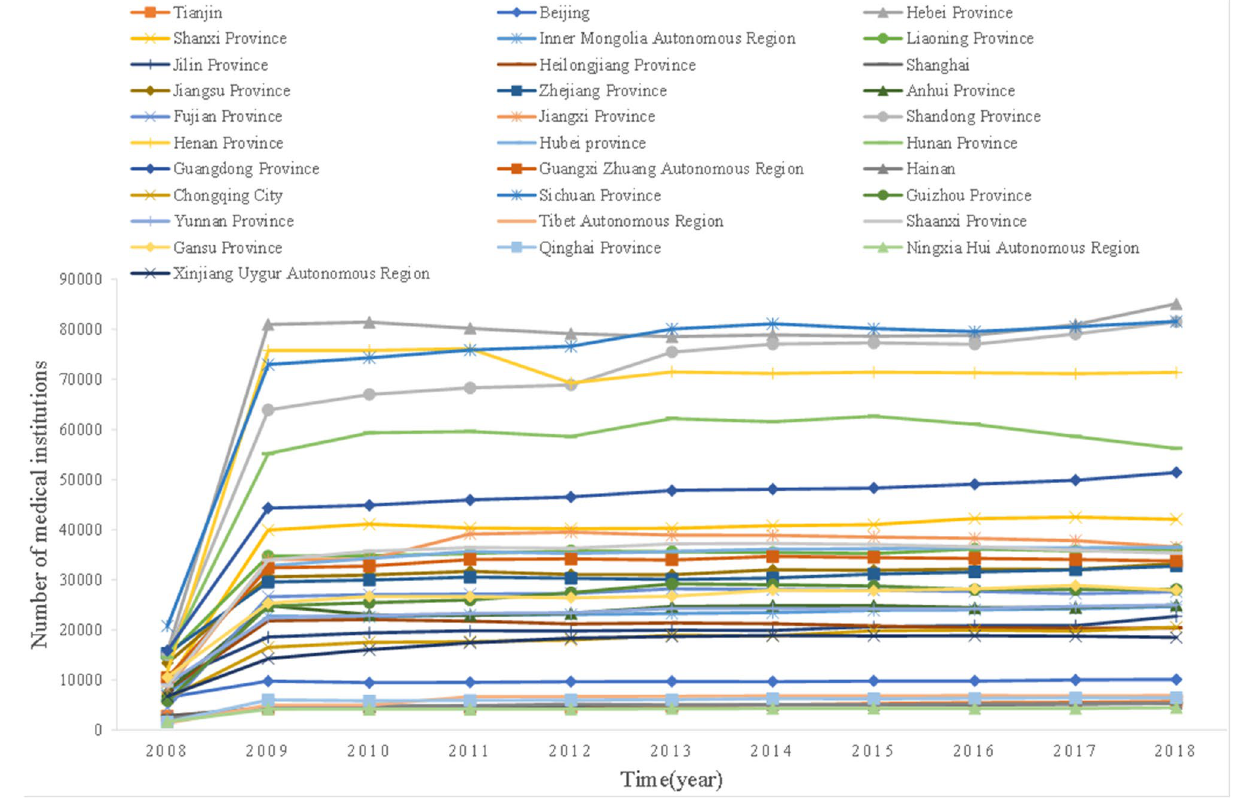
Figure 3. Changes in the number of medical institutions in China’s provinces and cities from 2008 to 2018.